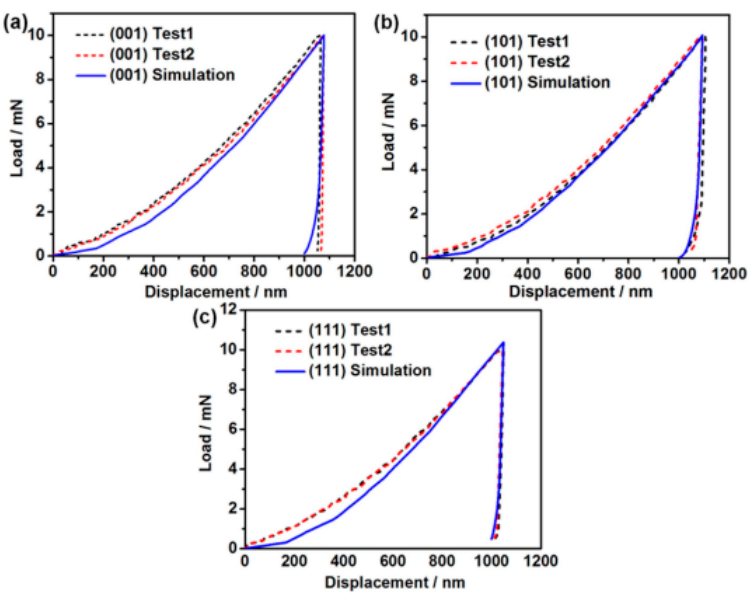
Figure 39. Comparisons between numerical and experimental load-displacement curves for single-crystal Al samples: ( a ) (001); ( b ) (101) and ( c ) (111) surfaces [136].